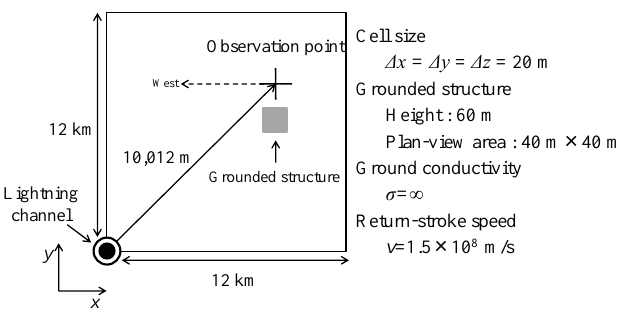
Figure 2. Plan view of the model for studying the influence of conducting structure (not to scale) on azimuth measured with respect to the west direction for the case of the true lightning azimuth φ = 45 ○ .